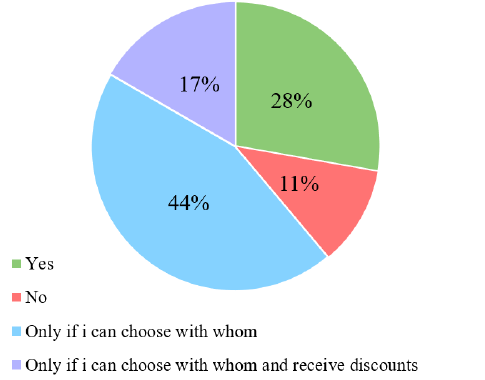
Fig. 7. Question: “Would you be willing to share your data with third-party